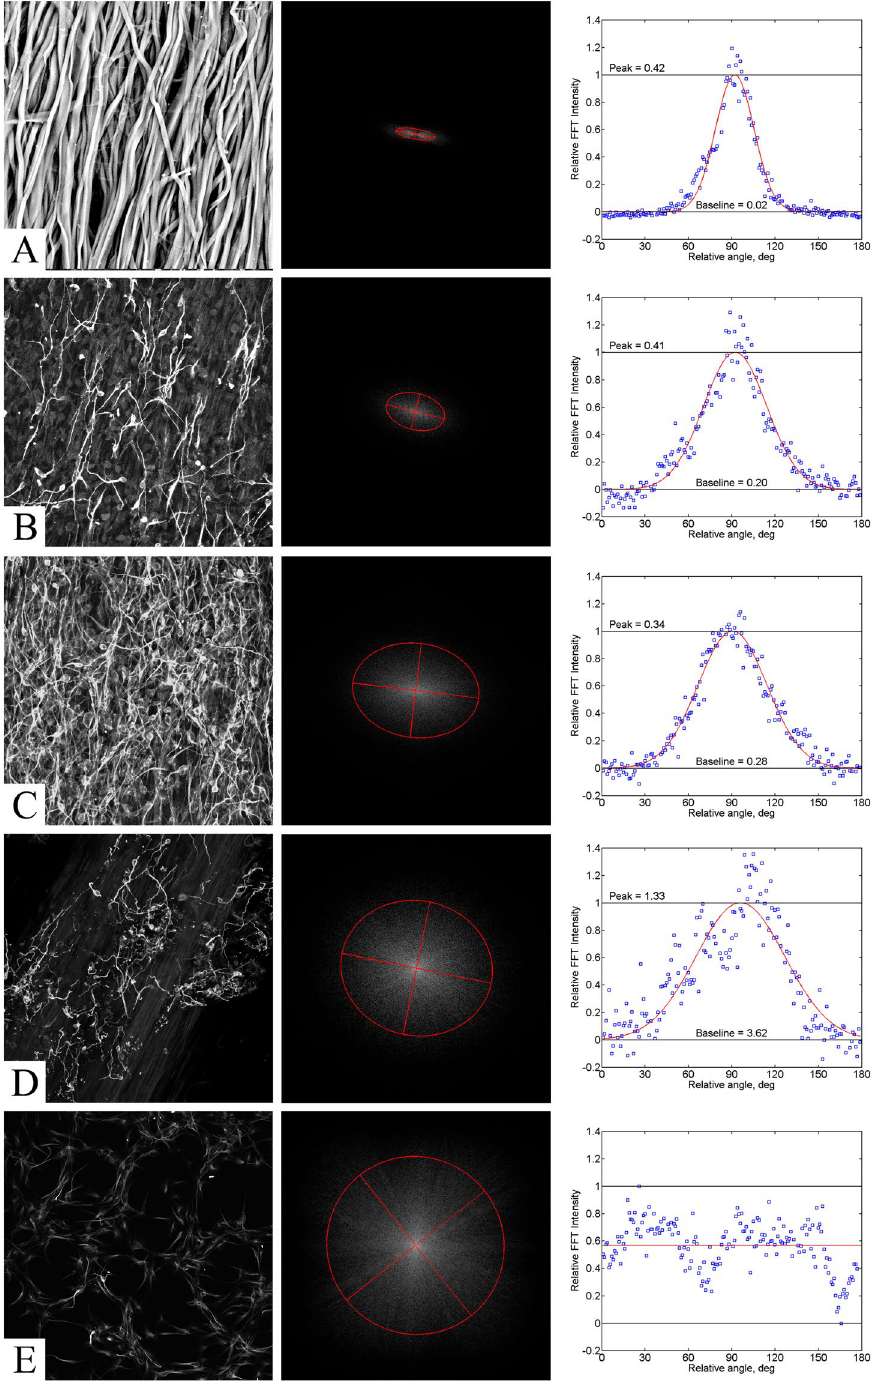
Figure 5. Analysis of structure alignment using image FFT and second order moments. ( A ) SEM of rSS-PCL scaffold; ( B ). MAP2 staining; drNPC in SPRPix matrix (rSS-PCL + PRP); ( C ). β III-tubulin staining; drNPC in SPRPix matrix; ( D ). β III-tubulin staining; drNPC in rSS-PCL scaffold; ( E ). β III-tubulin staining; drNPC cultured on isotropic surface. Left – original grayscale images; Middle – FFT images with equivalent covariance ellipses; Right – angular distribution of FFT intensity with normal